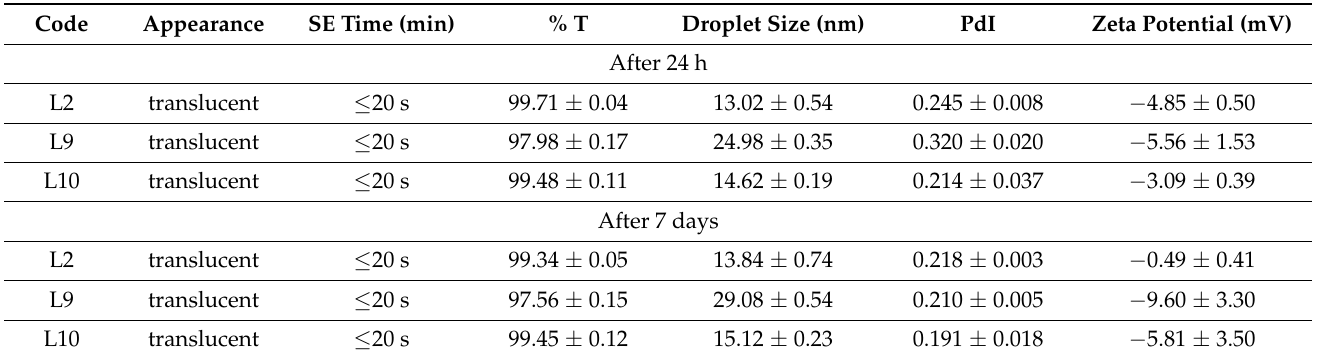
Table 7. Characterization of LYS:SDS-complex-loaded SEDDS after dilution (1:100) in distilled water 24 h after dilution and after 7 days.